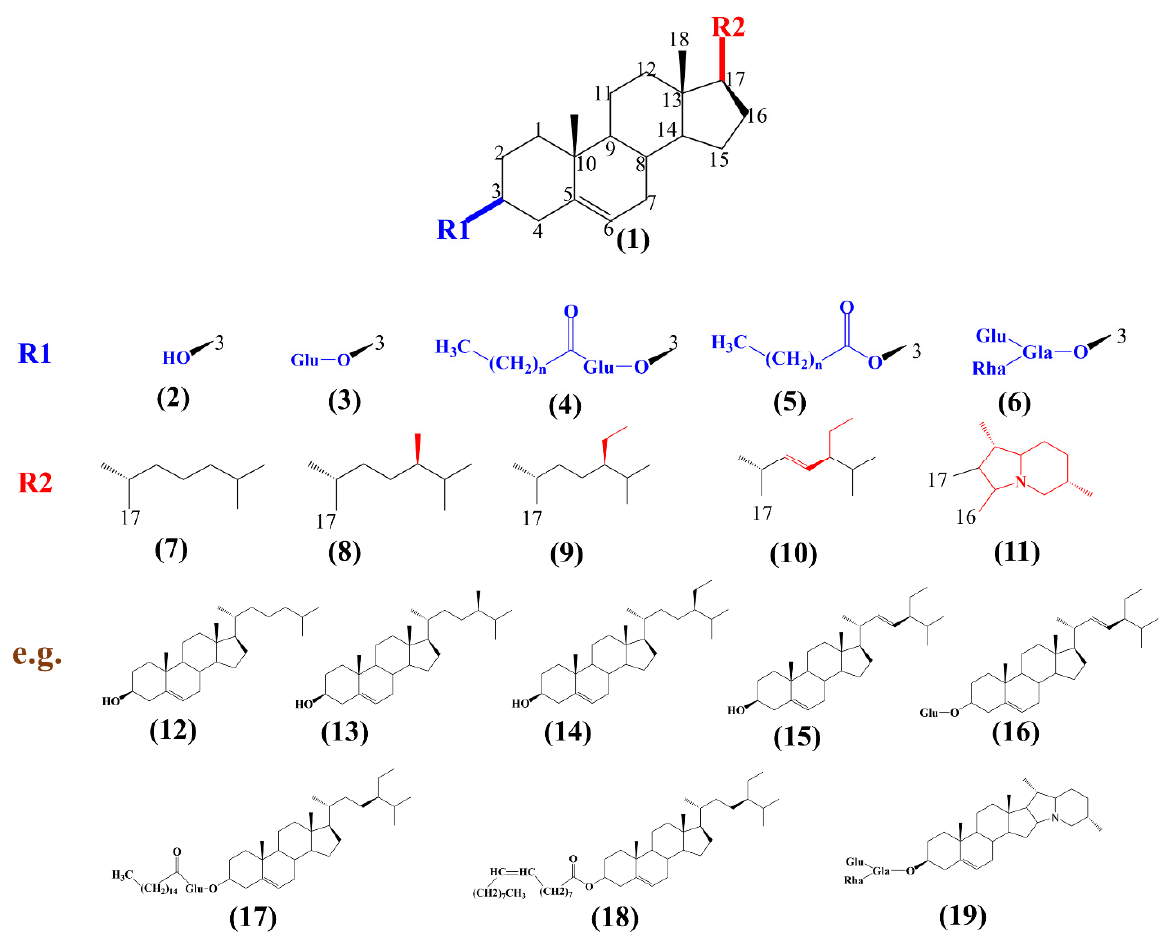
Figure 1. The chemical structure of free sterols and conjugated sterol. R1 at C3 and R2 at C17 determine the diversity of sterols. ( 1 ) Tetracyclic skeleton of sterol; R1 determines the type of compound including, ( 2 ) free sterol, ( 3 ) steryl glucosides, ( 4 ) acylated steryl glucosides, ( 5 ) steryl esters, ( 6 ) steroidal glycoalkaloids. R2 determines the diversity of compounds. For example, the combination of ( 2 ) and ( 7 ) makes cholesterol ( 12 ), the combination of ( 2 ) and ( 8 ) makes campesterol ( 13 ), the combination of ( 2 ) and ( 9 ) makes β -sitosterol ( 14 ), the combination of ( 2 ) and ( 10 ) makes stigmasterol ( 15 ), the combination of ( 3 ) and ( 10 ) makes stigmasteryl glycose ( 16 ), the combination of ( 4 ) and ( 9 ) makes sitosteryl palmitoyl glucoside ( 17 ), the combination of ( 5 ) and ( 9 ) makes stigmasteryloleate ( 18 ), while the combination of ( 6 ) and ( 11 ) makes α -solanine ( 19 ). The differences in the R1 group and R2 group are shown in blue and red, respectively.